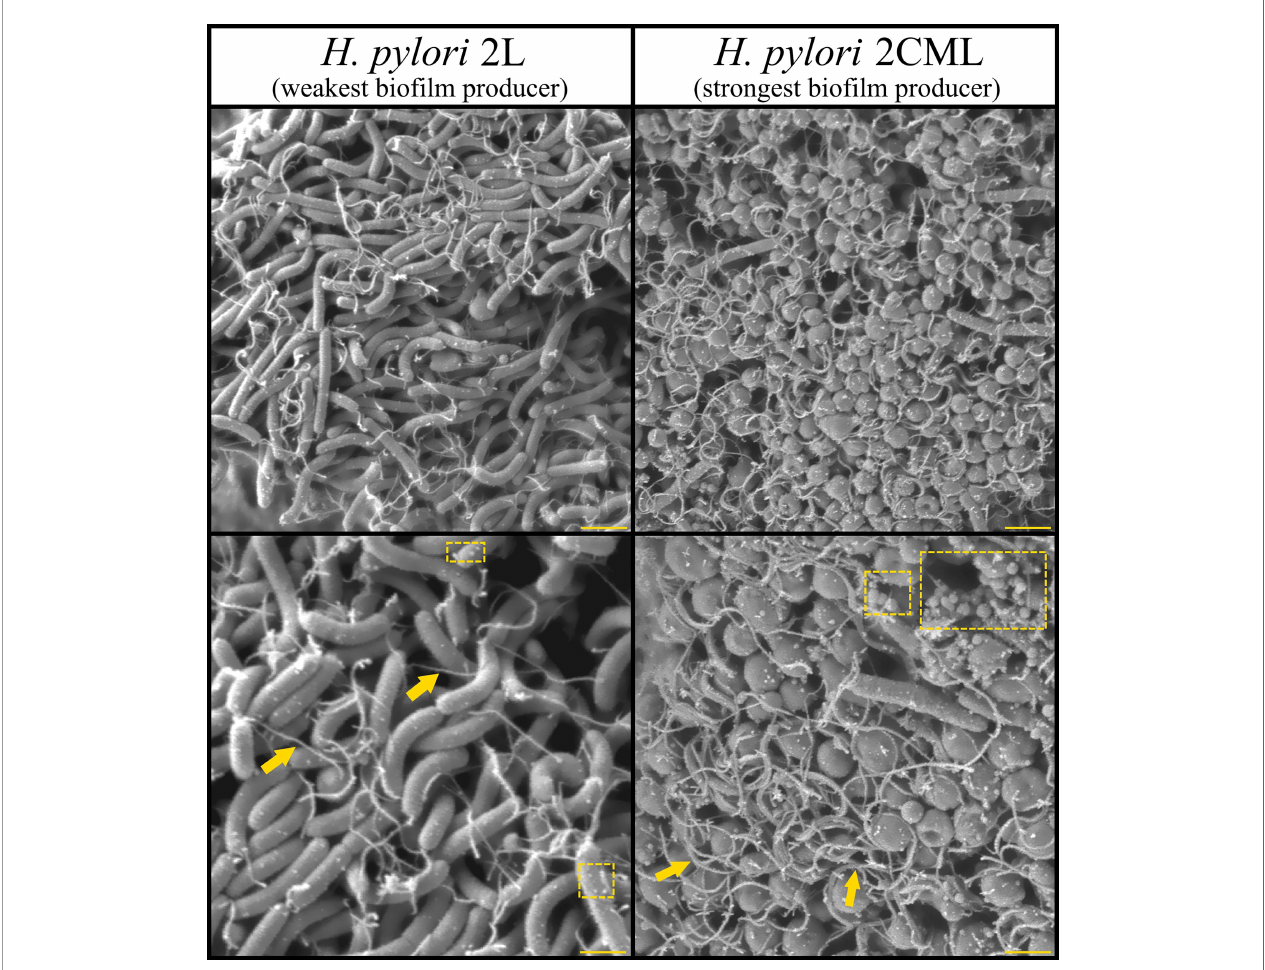
FIGURE 7 | Representative SEM photographs of bio fi lms formed after a 24-h incubation of H. pylori 2L and H. pylori 2CML strains on the solid surface. The arrows mark fl agella, while the squares with a dashed line indicate OMVs. Scale bars for the top images show 2 µm and for the bottom ones 1